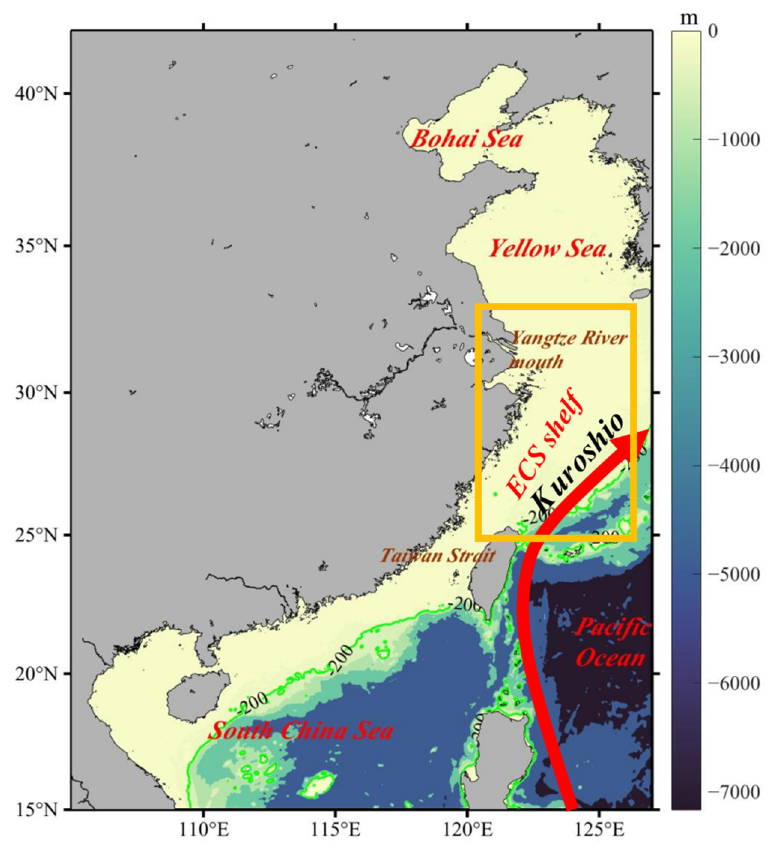
Figure 1. Geographical location and bathymetry of the ECS shelf. The yellow box is the cruise field and the green line is the − 200 m isobath.